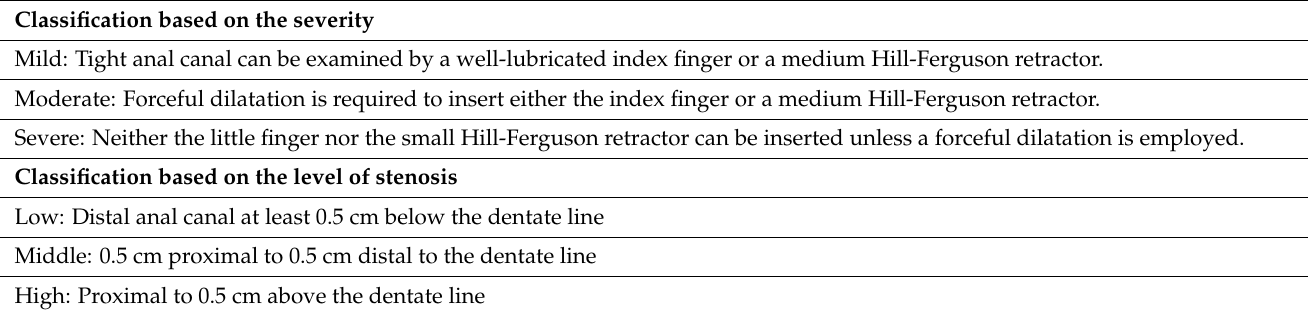
Table 1. Classification of anal stenosis by Milsom and Mazier [7].